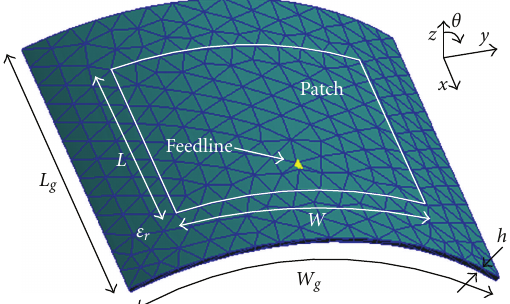
Figure 5: Geometry of a conformal microstrip antenna.